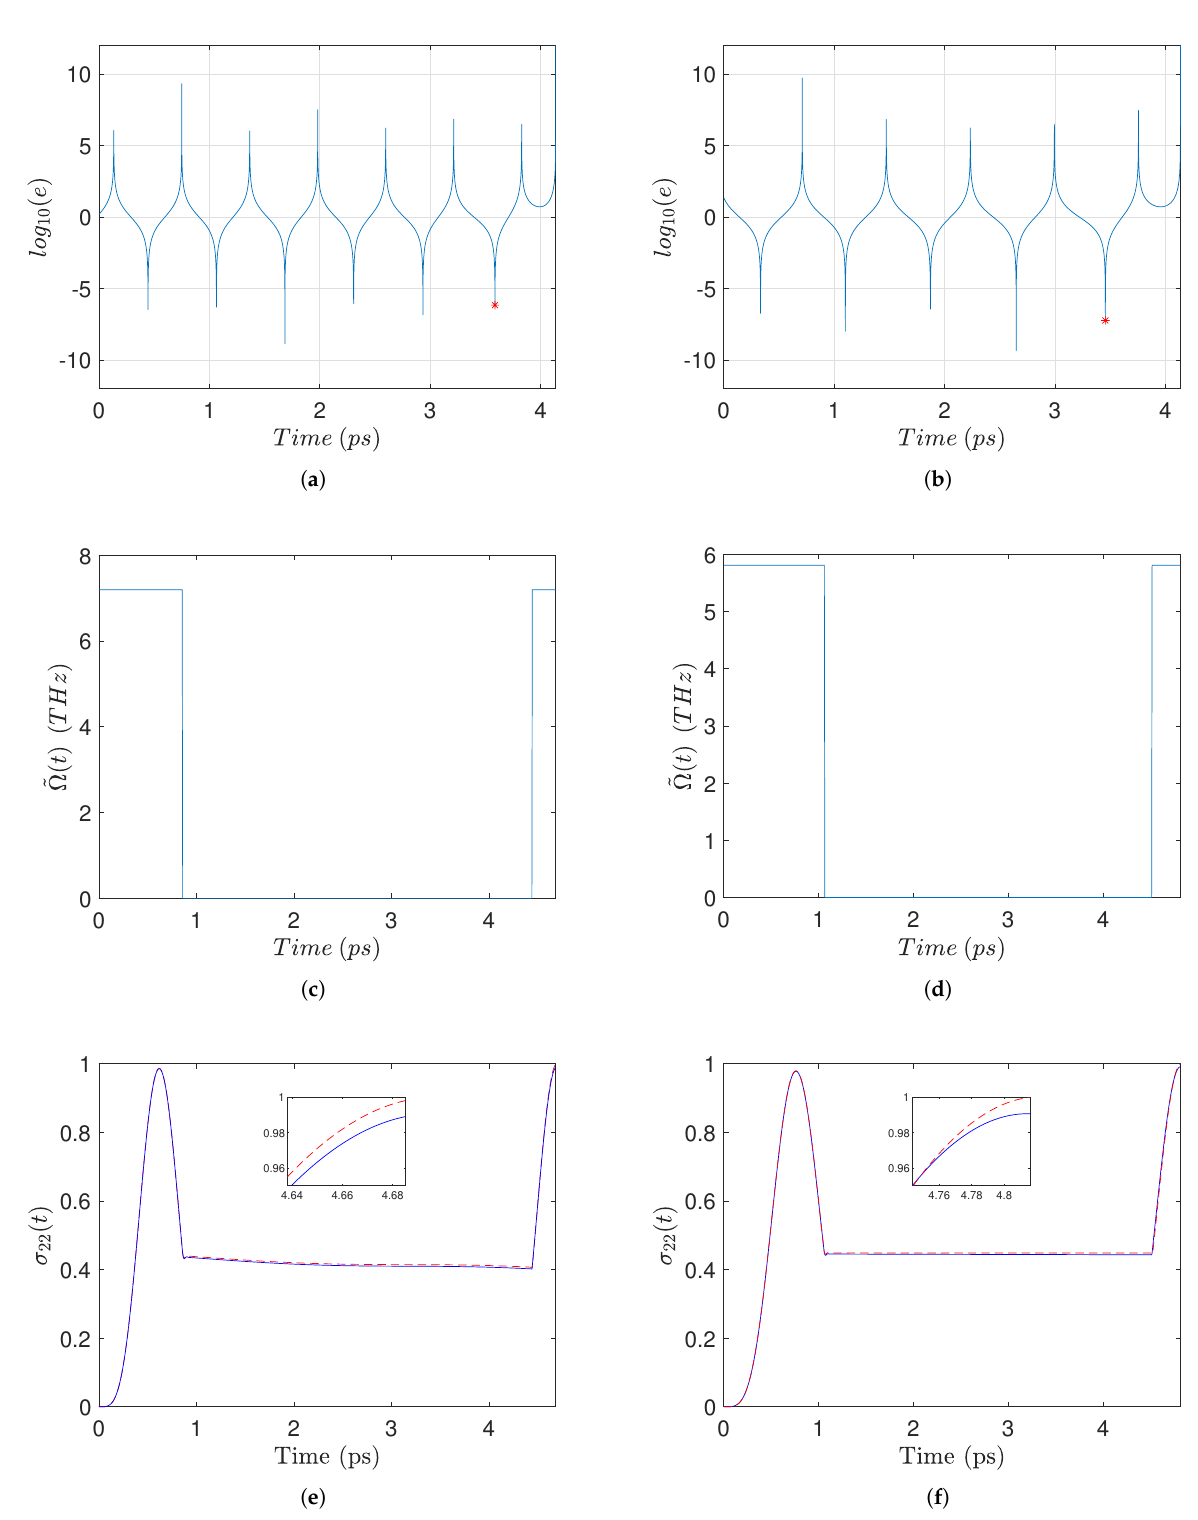
Figure 4. Left-column top to bottom: ( a ) Logarithmic squared error (28), ( c ) pulse-sequence, and ( e ) time evolution of σ 22 ( t ) , for R = 15 nm and E B = 1 meV. In the right-column ( b , d , f ) we display similar plots for the case with a larger interparticle distance R = 30 nm but the same biexciton energy shift E B = 1